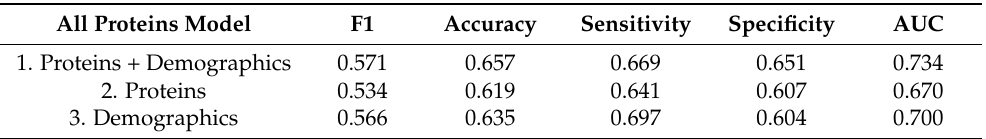
Table 4. Performance metrics of a machine learning classifier using only the 5 replicated proteins that were also CPAP responsive for moderate-to-severe OSA (AHI ≥ 15) trained on 974 samples (331 cases, 643 controls) and validated on 417 samples (142 cases, 275